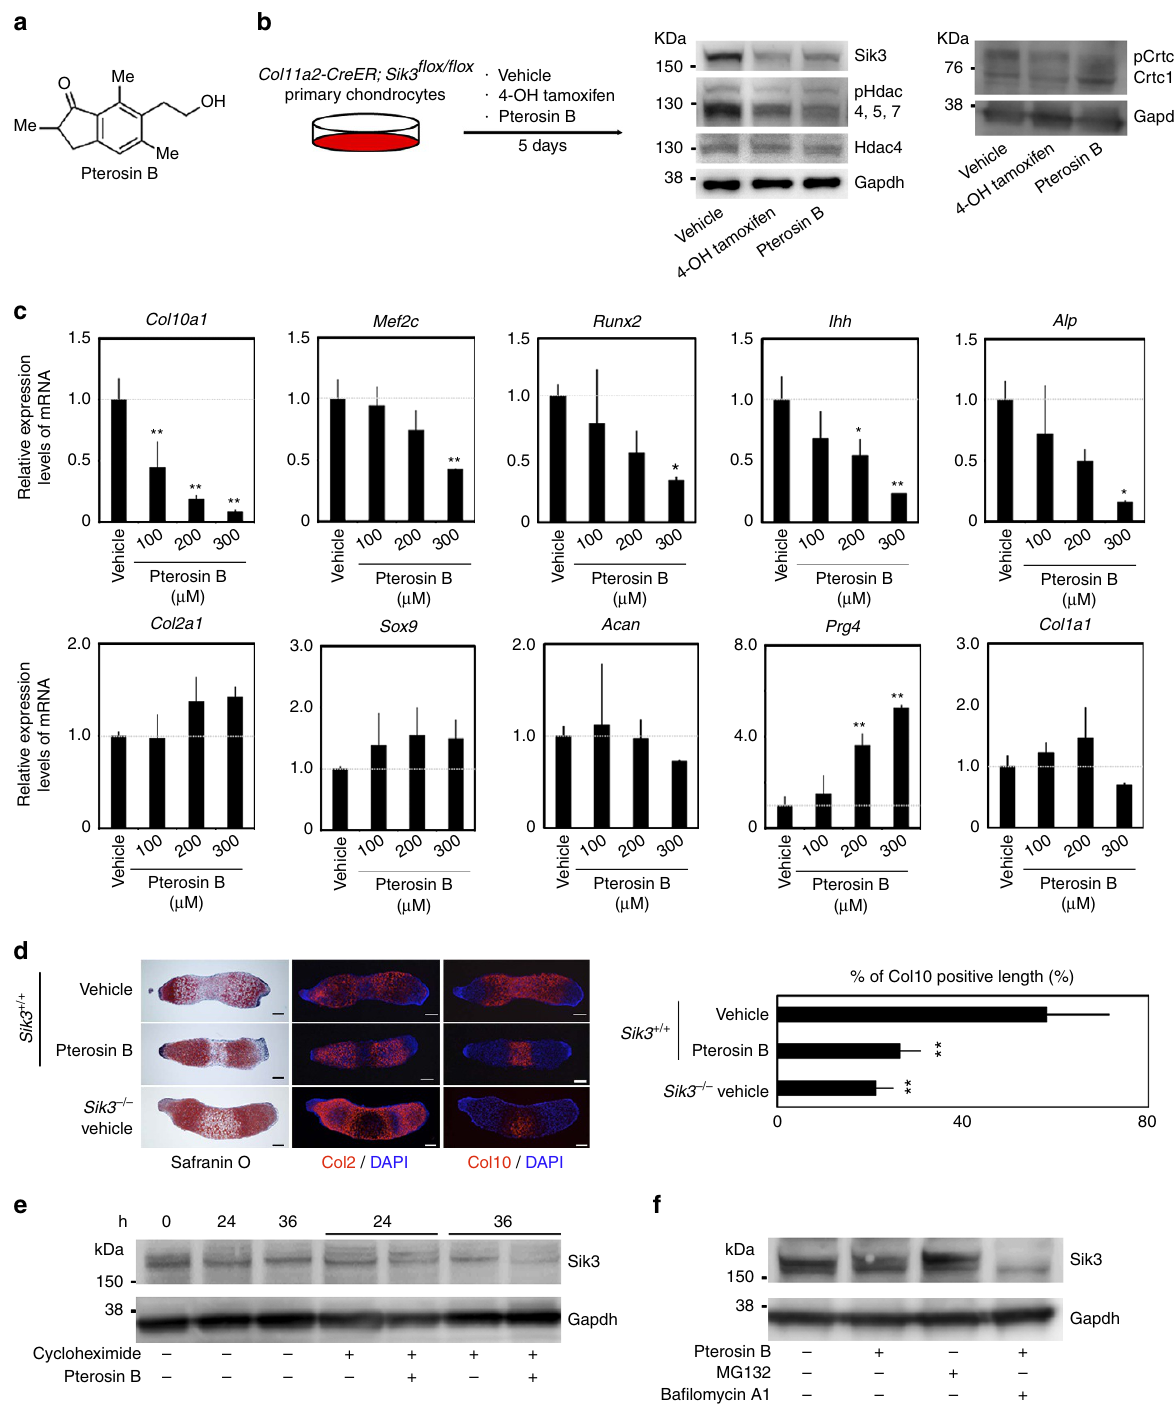
Figure 3 | Effects of pterosin B on chondrocyte differentiation in vitro . ( a ) Structure of pterosin B. ( b ) Primary chondrocytes prepared from Col11a2-CreER; Sik3 flox/flox mice were treated with vehicle, 0.5 m M 4-OH tamoxifen or 300 m M pterosin B for 5 days and subjected to western blot analysis. The images are representative of two independent experiments. ( c ) Real-time RT–PCR expression analysis of marker genes in pellet culture of mouse primary chondrocytes with pterosin B; n ¼ 3 pellets. ( d ) Metatarsal primordial cartilage from Sik3 þ / þ mice were organ-cultured in 300 m M pterosin B or vehicle. Metatarsal primordial cartilage from conventional Sik3 knockout mice were used for the control. Semiserial histological sections were stained with safranin O-fast green-iron haematoxylin and immunostained for Col2 and Col10. The percentage of Col10-postive area per total length in the axial direction is indicated; n ¼ 3 metatarsals. ( e ) Primary chondrocytes were treated with 100 m gml (cid:2) 1 cycloheximide in the presence or absence of 300 m M pterosin B. Cells were lysed after treatment for 0, 24 and 36h, and cell lysates were subjected to western blot analysis for Sik3 and Gapdh. The images are representative of two independent experiments. ( f ) Primary chondrocytes were incubated in the presence or absence of 1 m M MG132, 10nM bafilomycin A1 or 300 m M pterosin B for 36h. Cell lysates were subjected to western blot analysis for Sik3 and Gapdh. The images are representative of two independent experiments. Error bars denote the means ± s.d. * P o 0.05 and ** P o 0.01 by the Tukey–Kramer post hoc test. Scale bars, 100 m